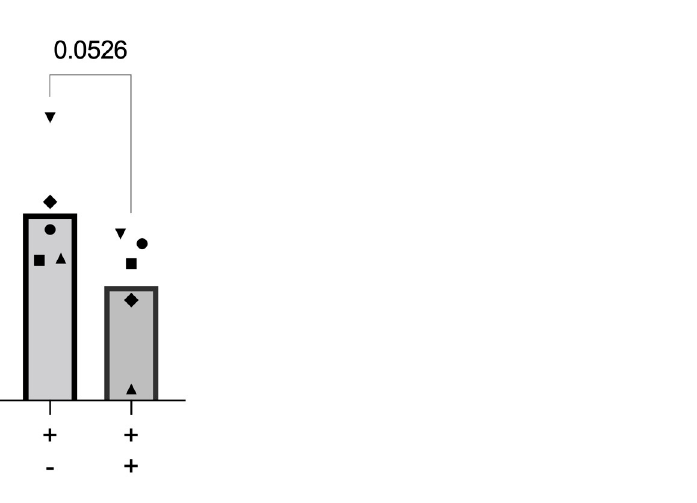
Figure 3. PRF reduced the ROS release provoked by LPS in activated RAW 264.7 macrophages. n = 5. To compare groups, paired t -test was applied.